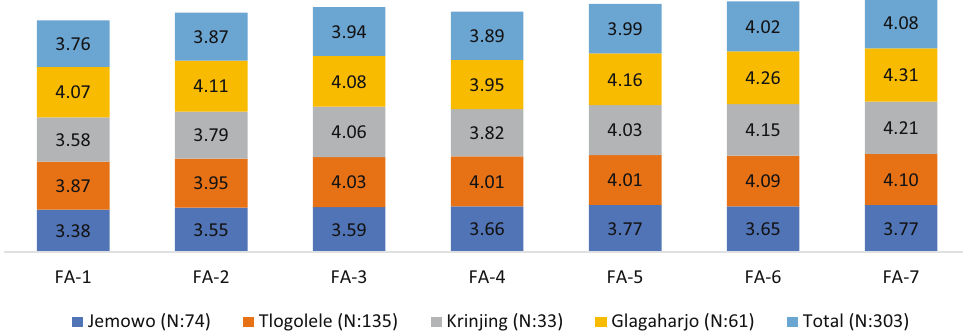
Figure 2: Mean of each indicator of food availability. FA - 1 ( in 1 year, there is a time when they do not have money or other resources ) ; FA - 2 ( worry about the insu ffi cient food consumption ) ; FA - 3 ( have to skip the meal ) ; FA - 4 ( eating less than the ideal consumption ) ; FA - 5 ( families face food shortage ) ; FA - 6 ( feel hungry but cannot eat ) ; FA - 7 ( does not eat for a whole day )